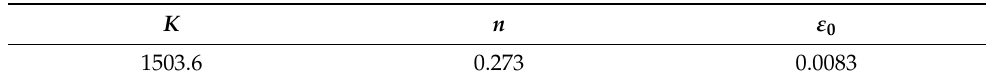
Table 1. Swift constitutive equation